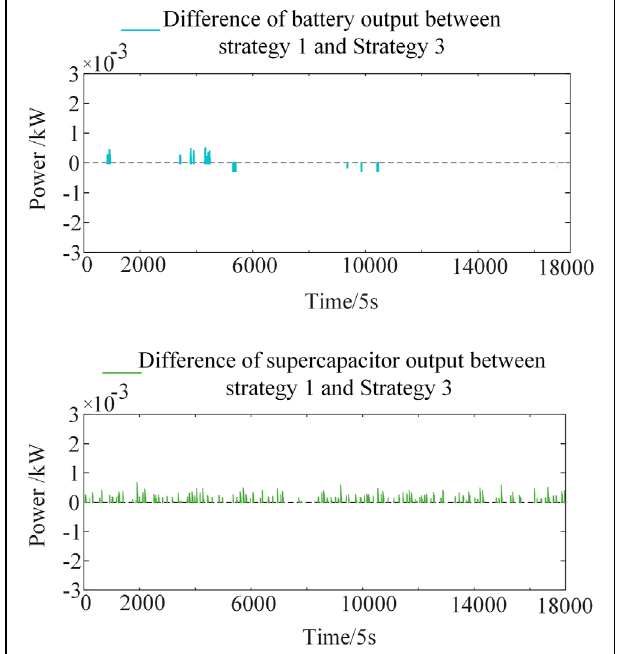
FIGURE 6 | Comparison of energy storage output between strategy 1 and strategy 3.